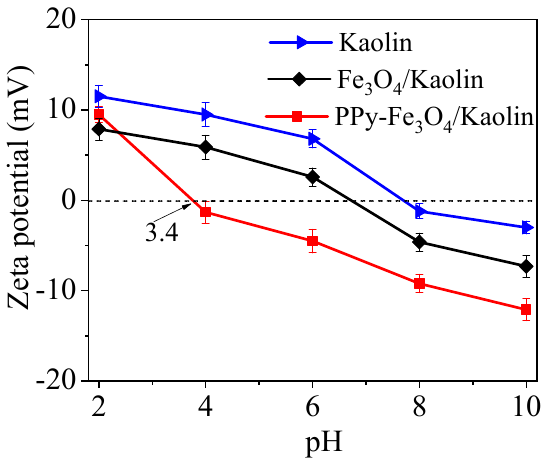
Figure 7. Zeta potential of Kaolin, Fe 3 O 4 /Kaolin and PPy-Fe 3 O 4 /Kaolin.